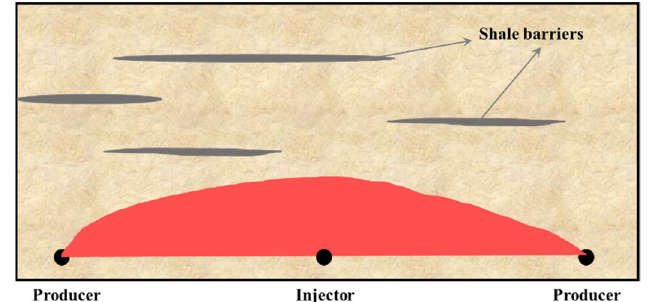
Figure 1. Schematic of the bottom ‐ up assisted pressure drive process with respect to the well loca ‐ tions, steam chamber characteristics, and shale barriers distribution. steam chamber characteristics, and shale barriers